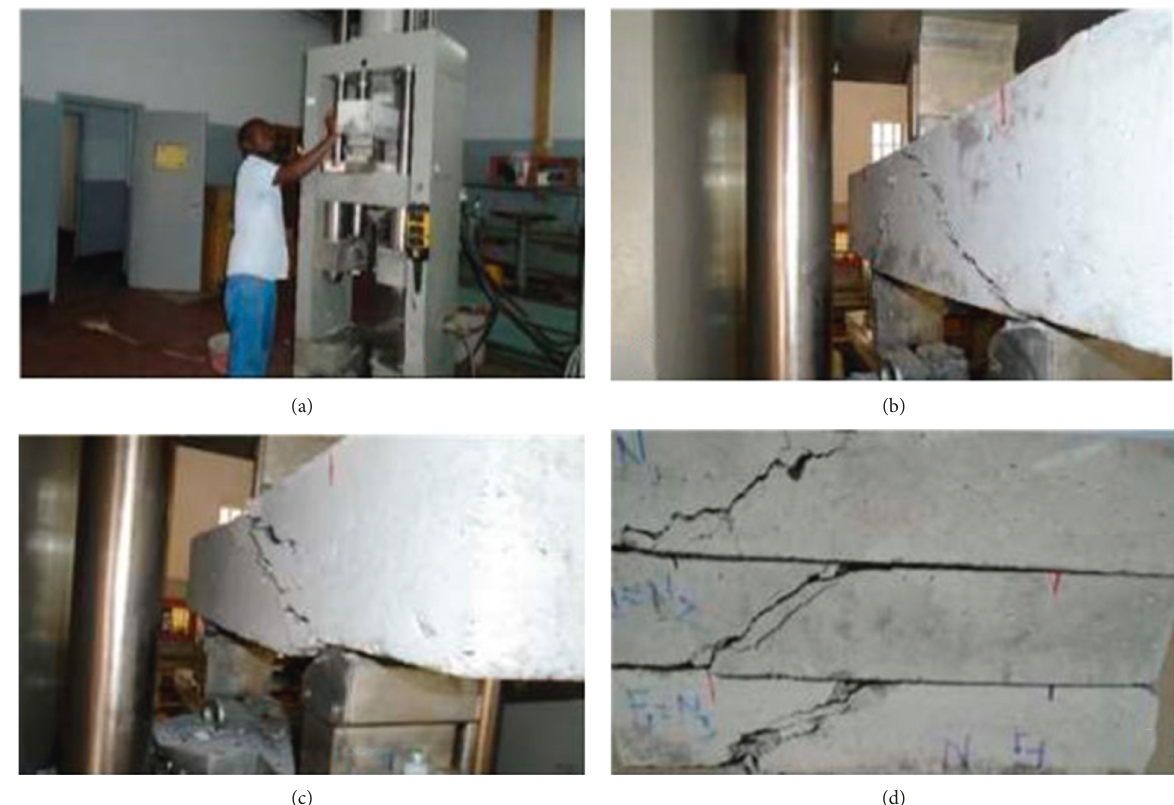
Figure 11: (a) Photos of failure of control beams, loading and marking, (b) photos of failure of control beams, testing, (c) photos of failure of control beams, starting of failure, (d) photos of failure of control beams, failure